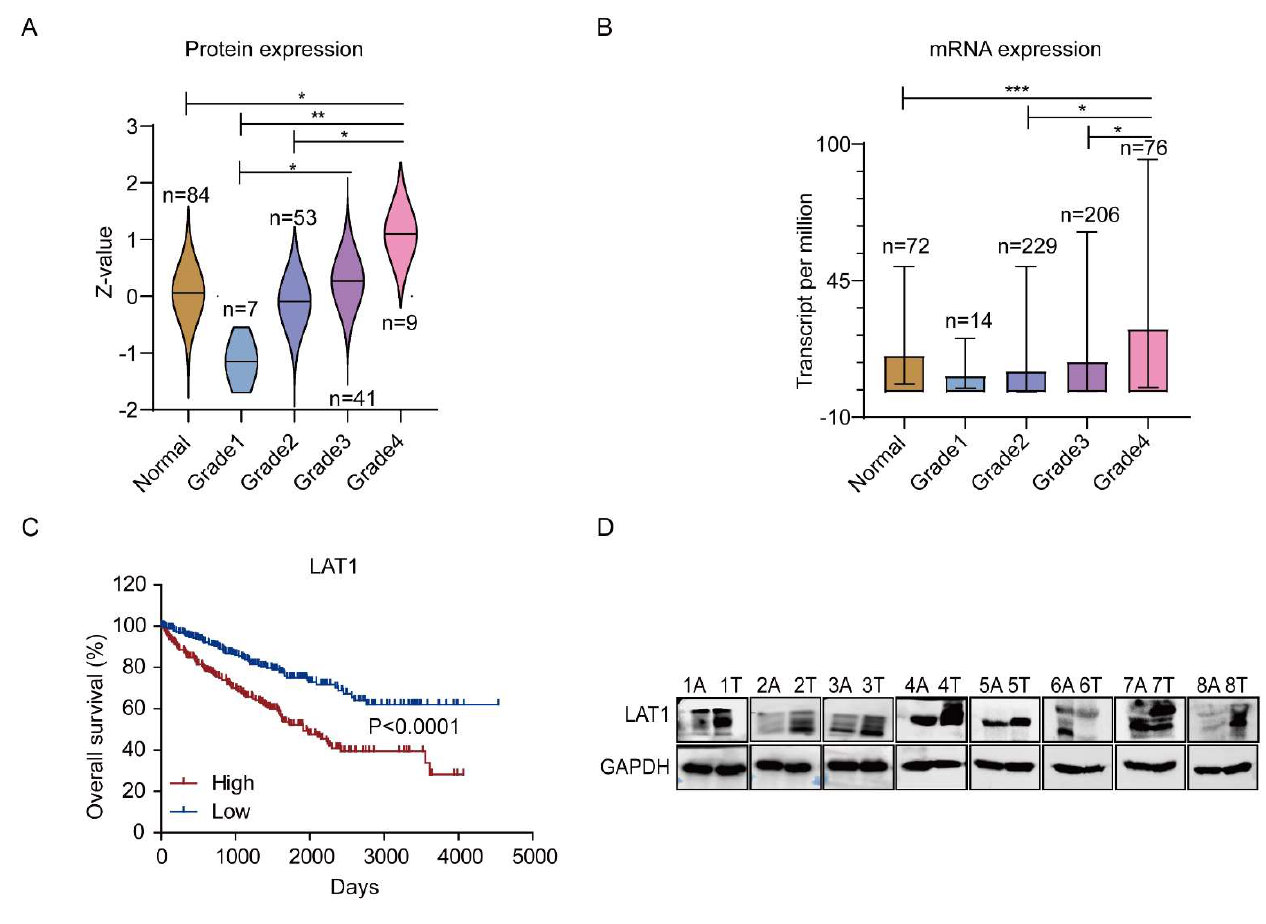
Figure 3. Clinical relevance of LAT1 expression to RCC. ( A ) The protein expression of LAT1 in RCC patients with different clinical stages. The data acquired from CPTAC database. Z values represent standard deviations from the median across samples for RCC. ( B ) The mRNA expression of LAT1 in RCC patients with different clinical stages. The data acquired from TCGA database. ( C ) Kaplan–Meier survival analysis of RCC patients with high and low LAT1 expression. ( D ) The protein expression of LAT1 in samples of matched RCC and adjacent non-tumor. A—adjacent tissue; T—tumor. GAPDH was used as an internal control. One-way ANOVA analysis was used. * p < 0.05; ** p < 0.01; *** p < 0.001.